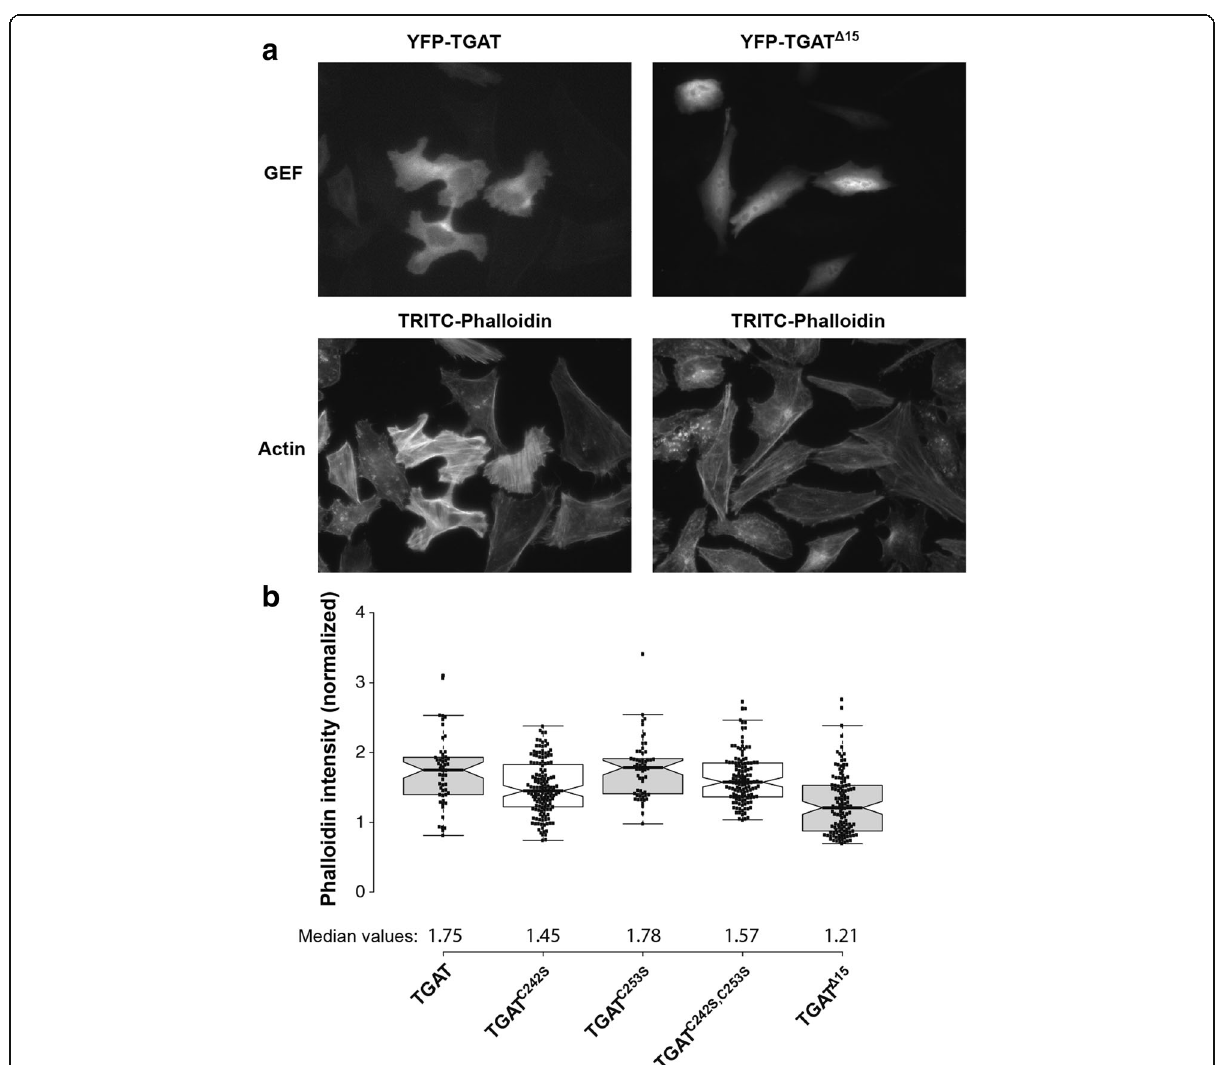
Fig. 5 Effect of TGAT mutant expression on actin polymerization. a Representative images of HeLa cells transfected with YFP-TGAT or YFP- TGAT Δ 15 ( top ), stained with TRITC-phalloidin ( bottom ). b Quantification of F-actin in HeLa cells transfected with YFP-TGAT ( n = 53), YFP-TGAT C242S ( n = 147), YFP-TGAT C253S ( n = 58), YFP-TGAT C242S, C253S ( n = 128), YFP-TGAT Δ 15 ( n = 126) and stained with DAPI and TRITC-phalloidin, as determined by the fluorescent intensity of the TRITC-phalloidin staining. Actin intensity of transfected cells was normalized to the intensity of untransfected control cells in the same field of